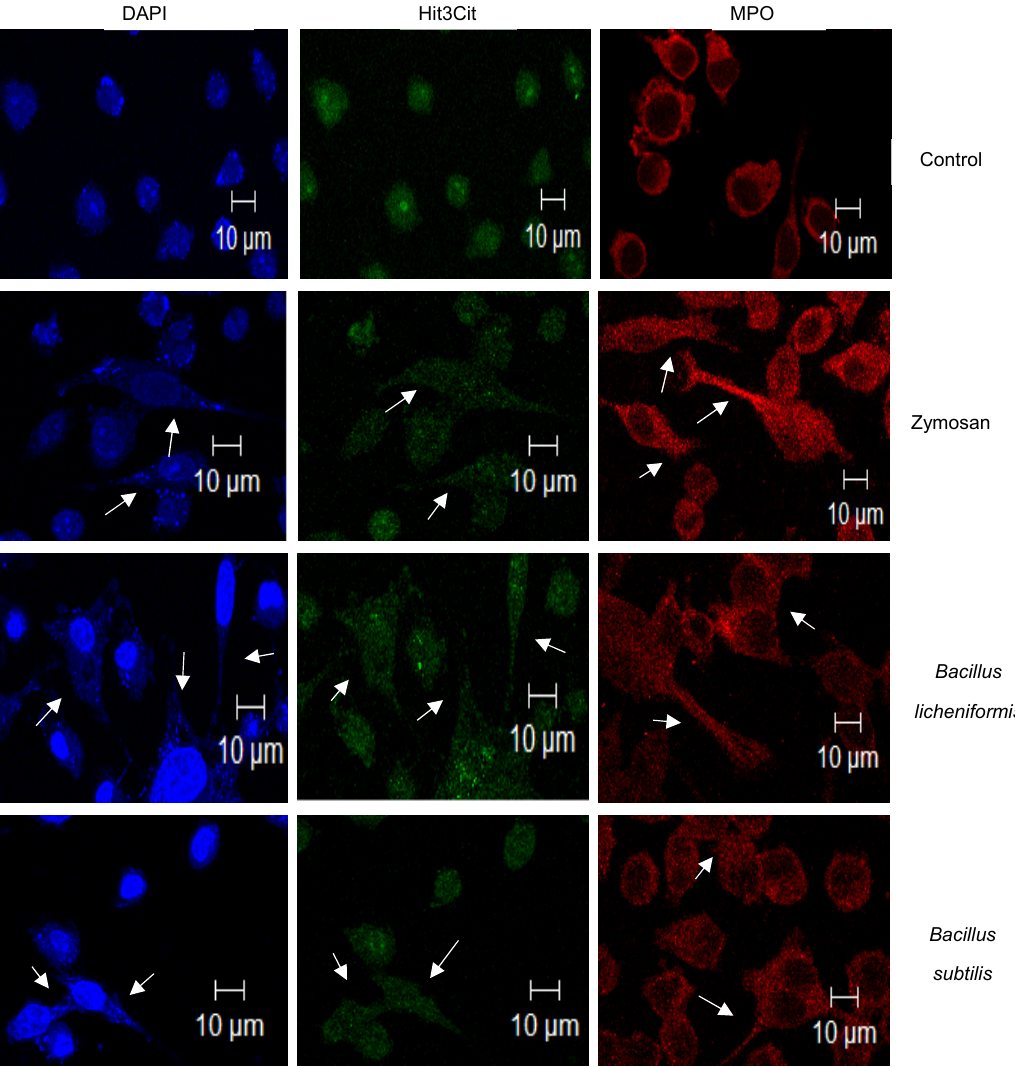
Figure 2. Bacillus licheniformis and Bacillus subtilis induce the formation of macrophage extracellular traps. Macrophages were infected or treated with zymosan for 3 h. Immunofluorescence showed the presence of nuclear and cellular distribution of Hit3Cit (green), MPO (red), and nuclear DNA (blue), fundamental components of METs. Arrows pointed to METs extensions containing DNA, Hit3Cit, and MPO. Representative images of three experiments. The preparations were observed under a confocal microscope at 630 ×